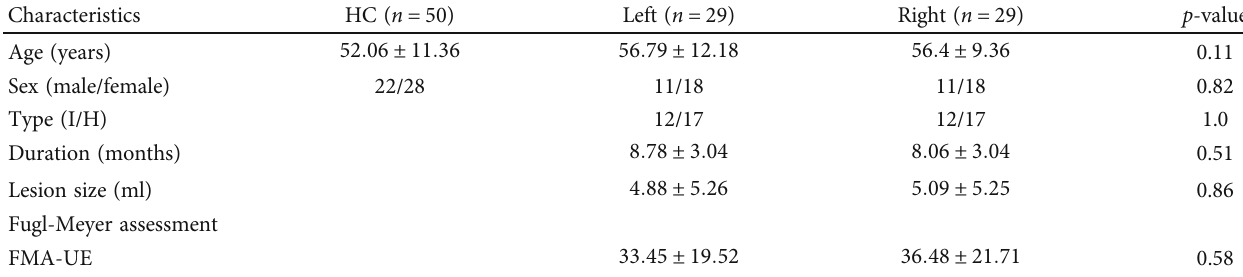
Table 1: Demographic and clinical data of stroke patients and healthy